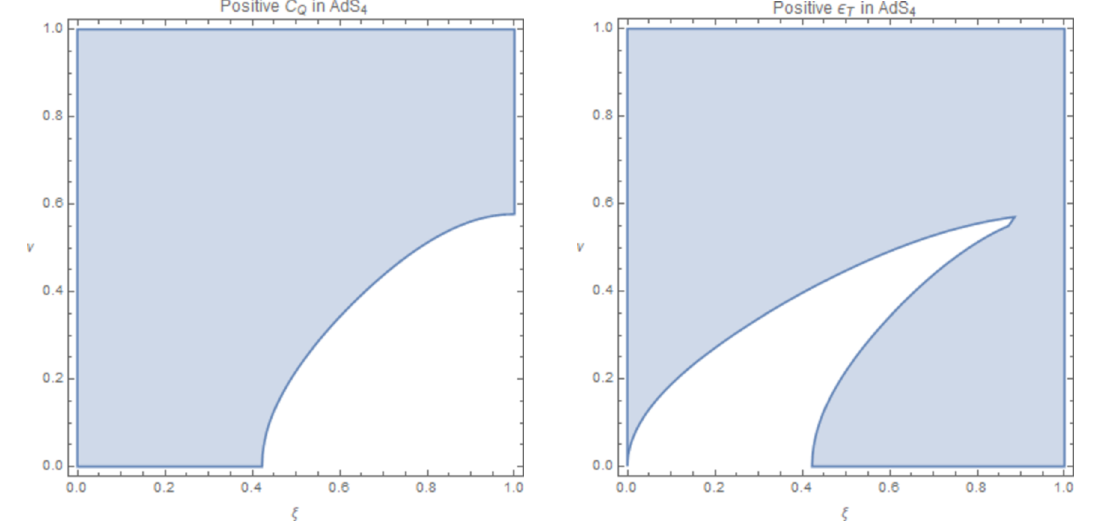
Figure 1 . Blue represents the regions of parameter space where each quantity is